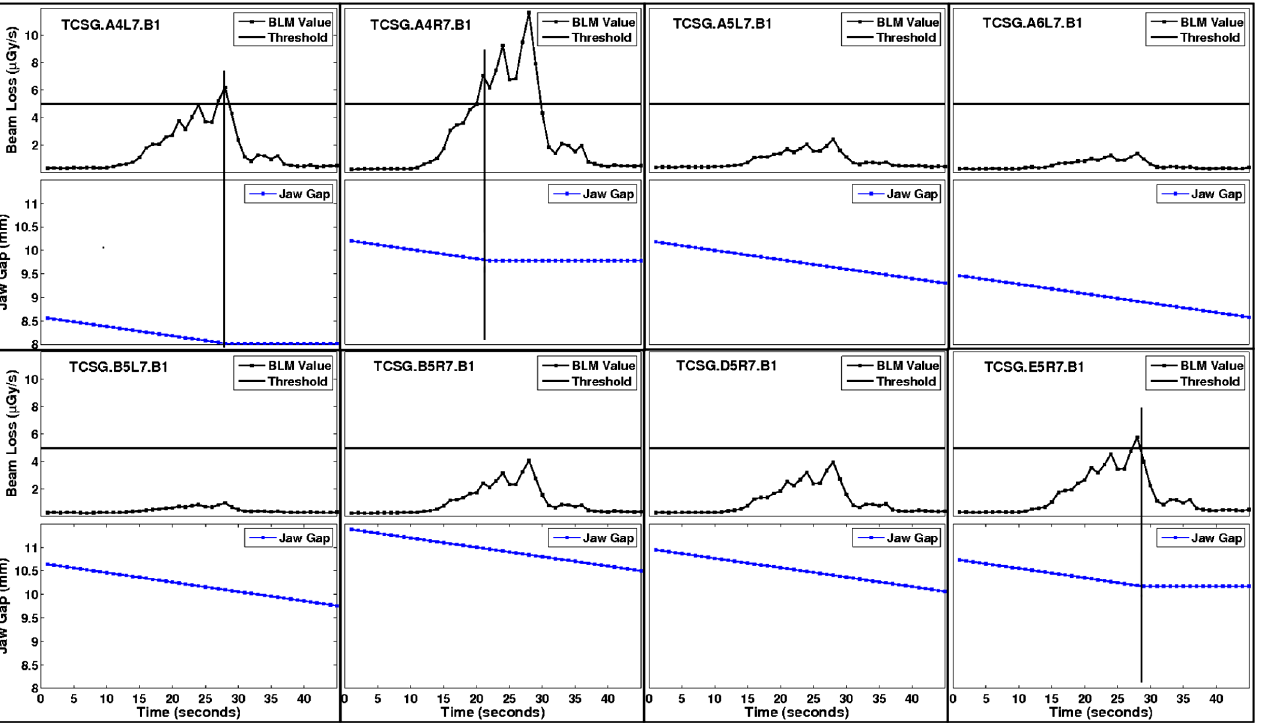
FIG. 7. Both jaws of eight skew B1 collimators moving in parallel. The similarity of the loss spike patterns detected on each BLM and the simultaneous stopping of three collimators highlights the need for being able to automatically identify which collimator jaw is actually aligned to the beam. A perpendicular line is used to show how the jaw stops when the losses exceed the threshold for these